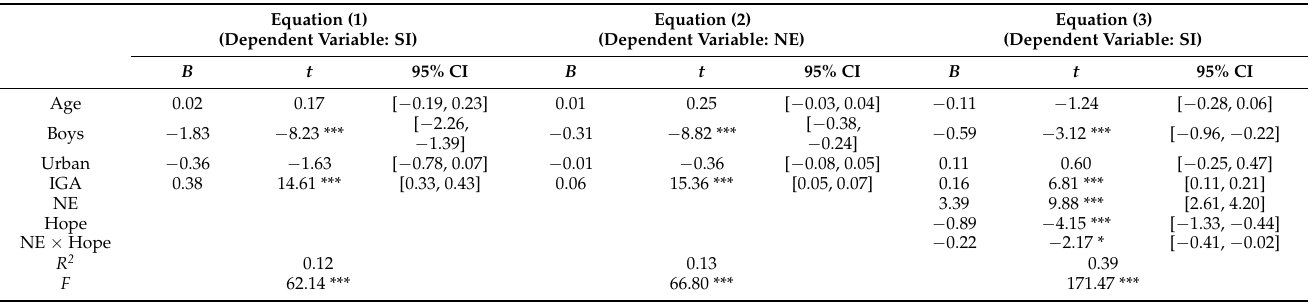
Table 3. Tests for mediating effects with moderation.